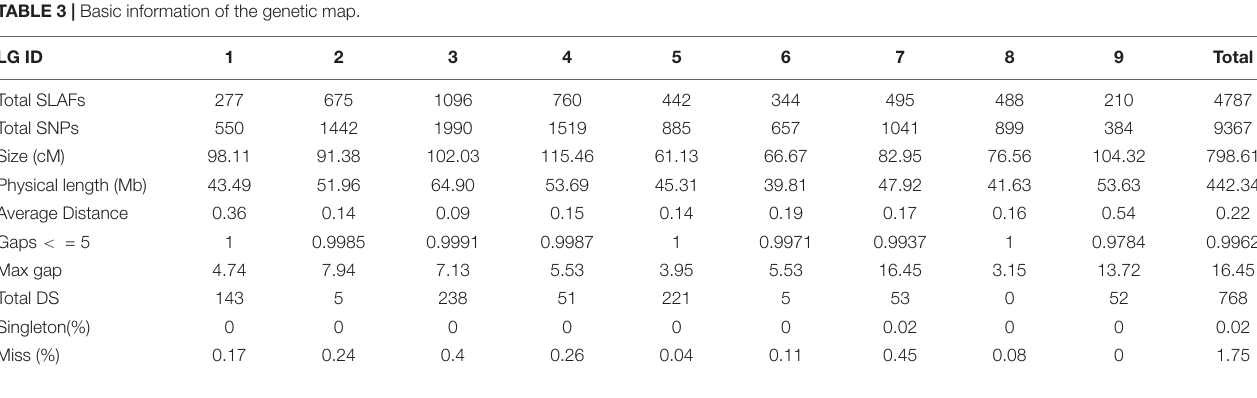
FIGURE 4 | The broccoli genetic map based on the reference genome TO1000. The x -and y -axis are for linkage group and genetic distance, respectively. Red line in the map is for partial separation markers, and the black one is for normal markers. TABLE 3 | Basic information of the genetic